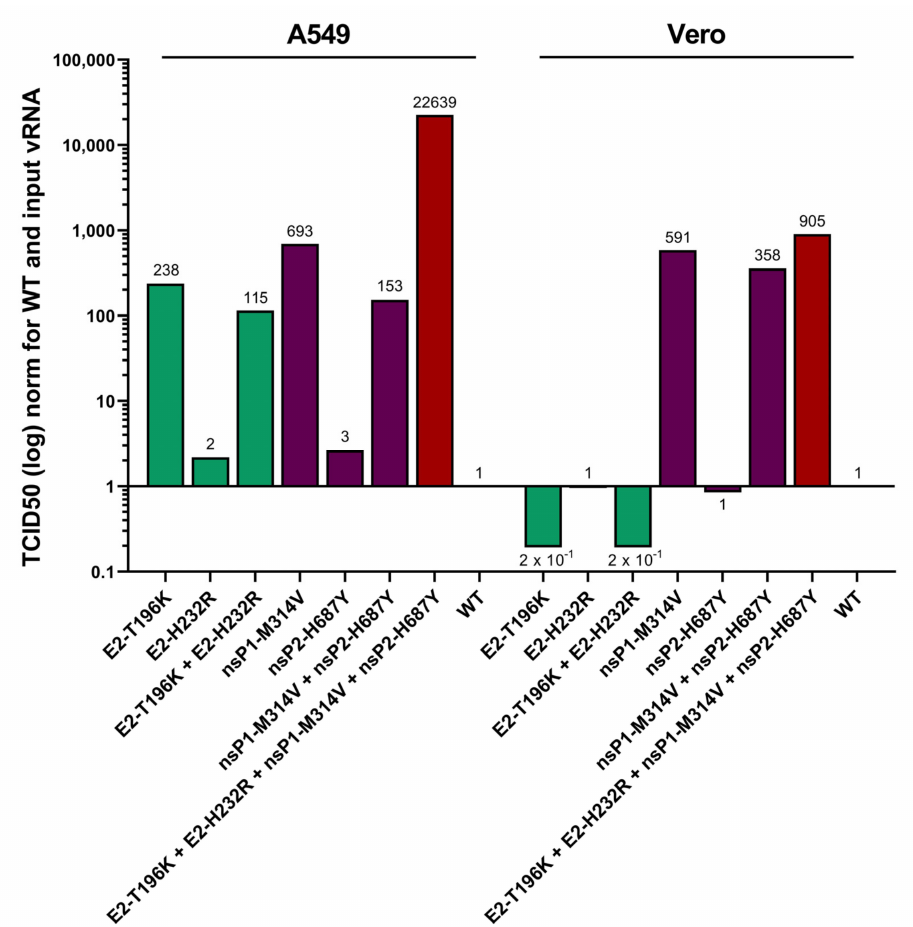
Figure 3. Effect of A549 acquired mutations on infectivity in Vero and A549 cells. Vero cells were transfected with viral RNA carrying the different mutations. After 48h, supernatant was harvested, and TCID50 on Vero and A549 cells was calculated. TCID50 was calculated using the Spearman- Kärber method from 6 replicates of each titration. TCID50 was first normalized for input vRNA determined using RTqPCR followed by normalization for WT CHIKV for each cell